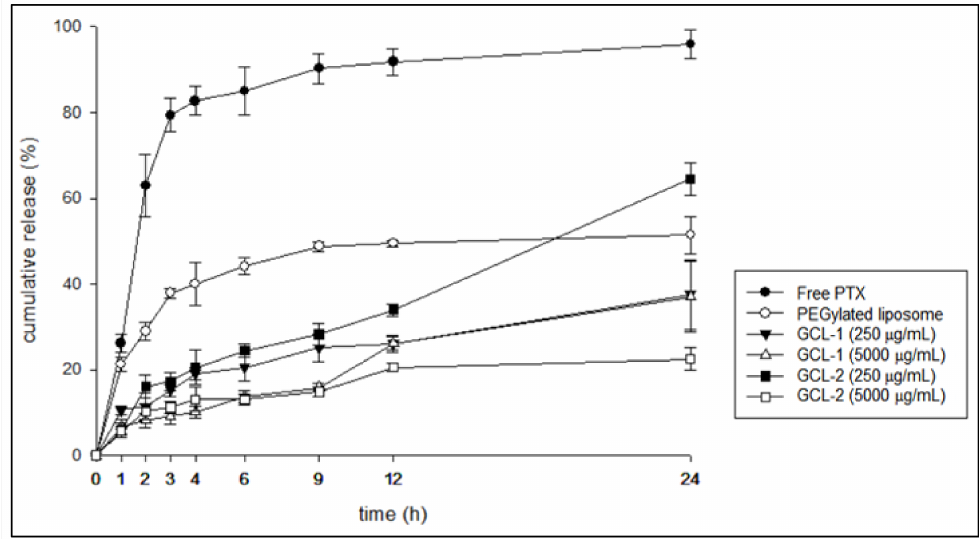
Figure 6. In vitro release profiles of the liposome formulations and free